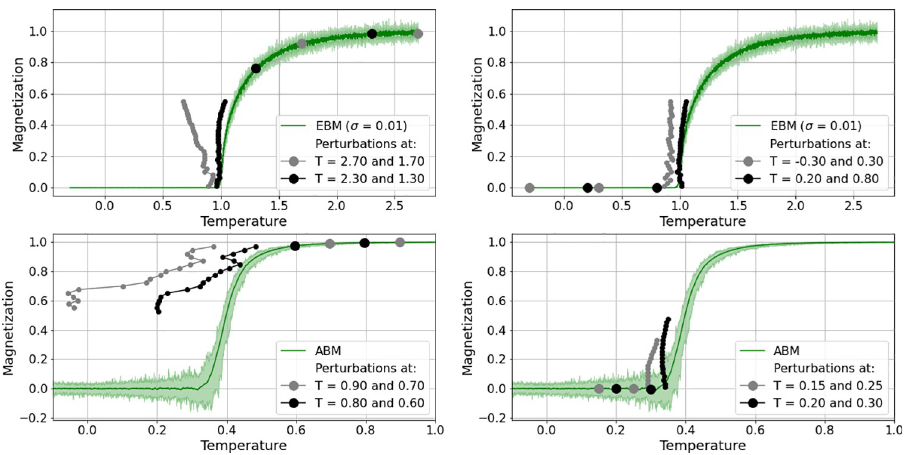
Fig 7. Comparison of pitchfork bifurcation predictions from perturbations. Applied at the above-transition range of temperature (left column) and at the below-transition range of temperature (right column), on EBM-generated data (top row) and ABM-generated data (bottom